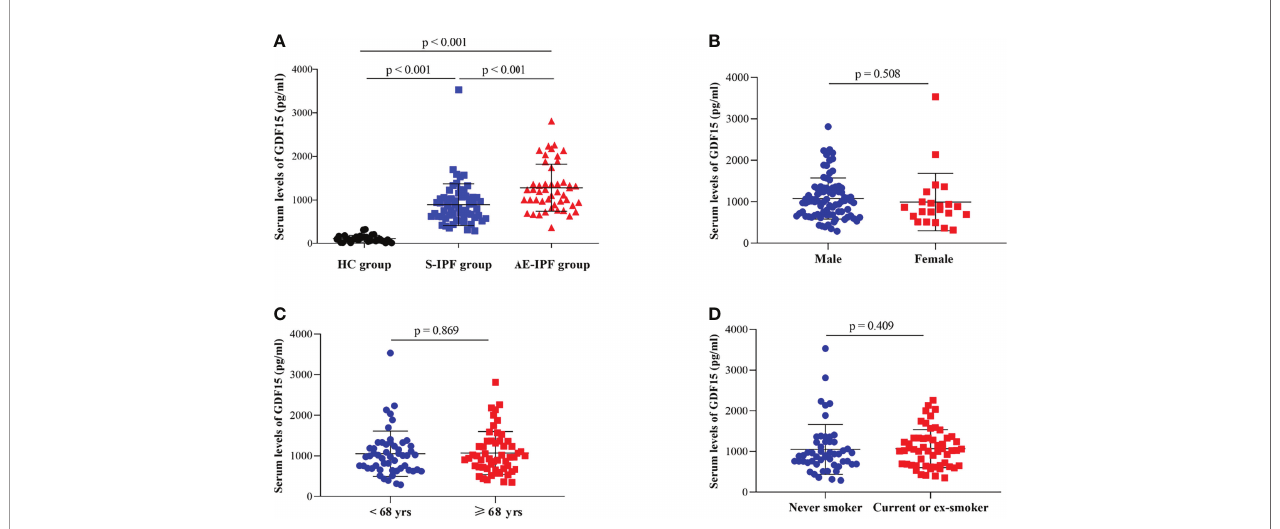
FIGURE 1 | Serum levels of GDF-15 in IPF patients. (A) Serum GDF-15 concentrations were elevated signi fi cantly in AE-IPF patients compared with HCs and S-IPF cases (p < 0.001 and p < 0.001, respectively). Serum GDF-15 levels were also increased signi fi cantly in S-IPF subjects compared with HCs (p < 0.001). (B – D) The differences of serum GDF-15 levels were not signi fi cant in the different gender, age, and smoking history of IPF patients (p = 0.508, p = 0.869 and p = 0.409, respectively).